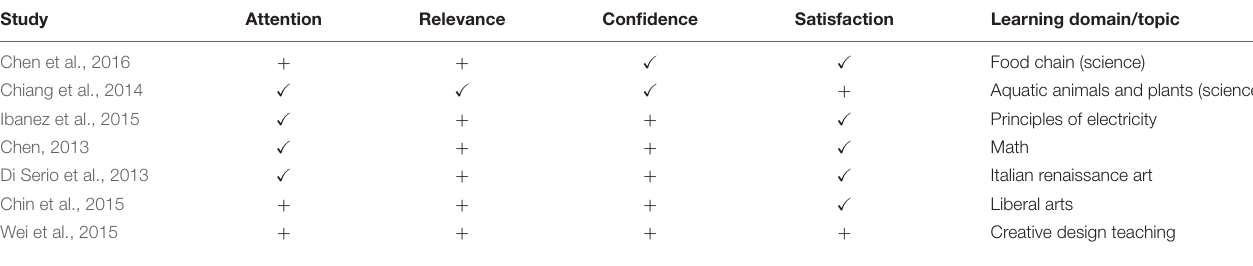
TABLE 1 | Studies that used the ARCS model to analyze the impact of AR on student motivation.